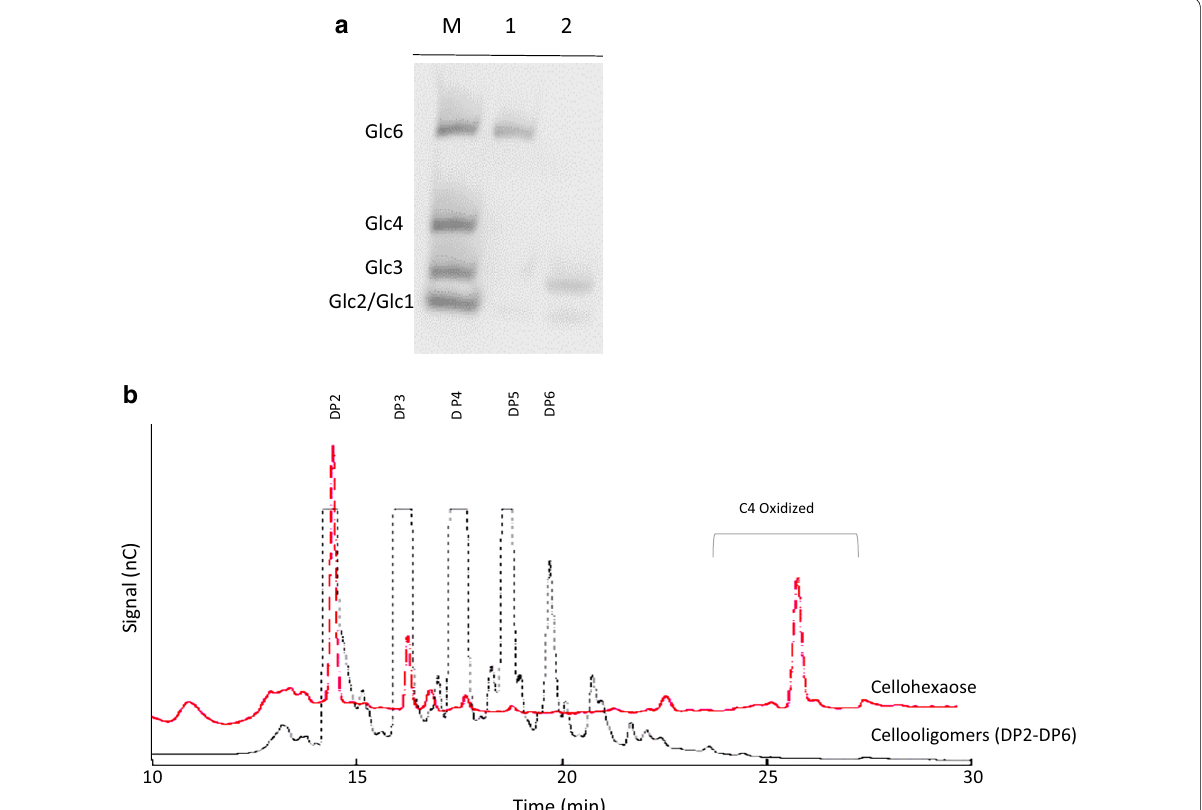
Fig. 3 Activity of AN1602 on cellohexaose. a PACE gel showing digestion products from cellohexaose upon AN1602 activity in the presence of 1 mM ascorbic acid. Lane 1—cellohexaose, lane 2—cellohexaose treated with AN1602. The migration standards (M) are cello-oligosaccharides corresponding to Glc2 (cellobiose), Glc3 (cellotriose), Glc4 (cellotetraose) and Glc6 (cellohexaose). b HPAEC chromatogram showing the generation of native and oxidized oligosaccharides after incubating cellohexaose (0.5 mg/mL) with AN1602. A mixture of nonoxidized cello-oligosaccharide (DP2-6) standards in the control run is also shown. Analysis was carried out after treating cellohexaose with AN1602 under similar conditions as in Fig. 2a. nC